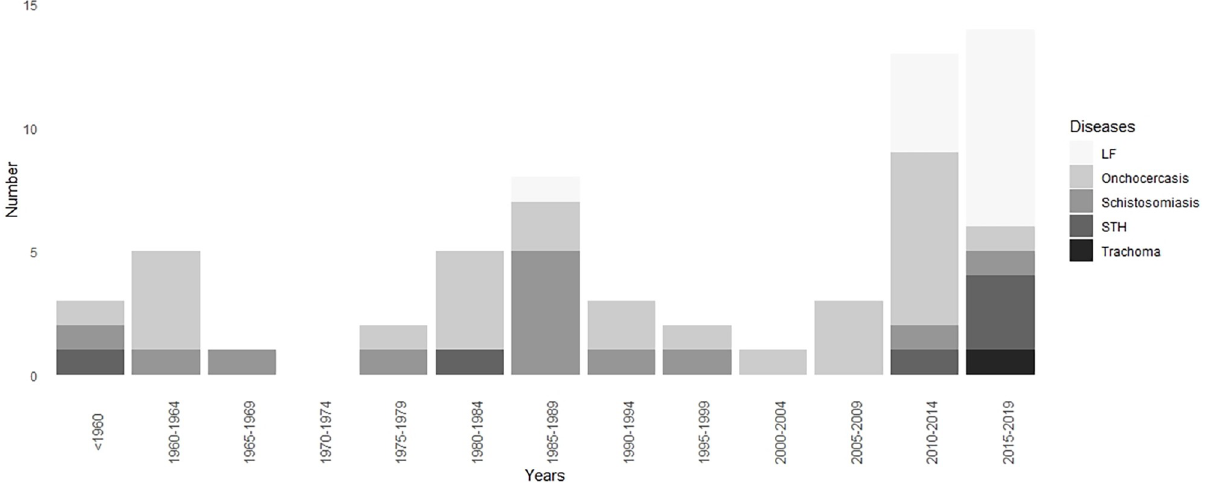
Fig 2. History of the number of articles and reports published for each PC-NTD (before 1960 then during each 5-year period).